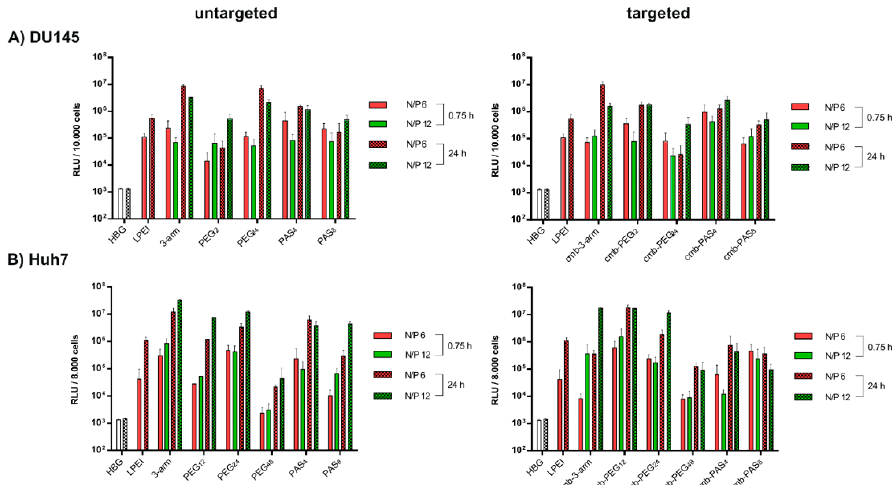
Figure 5. Cont. Figure 5.